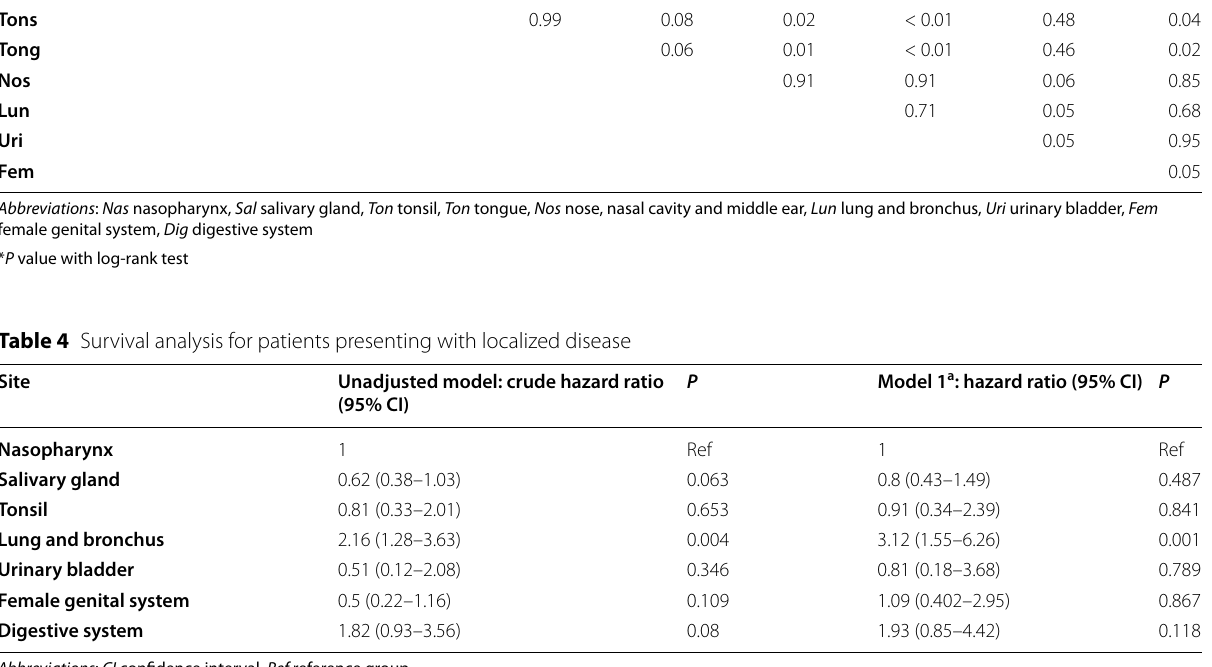
Abbreviations : CI confidence interval, Ref reference group